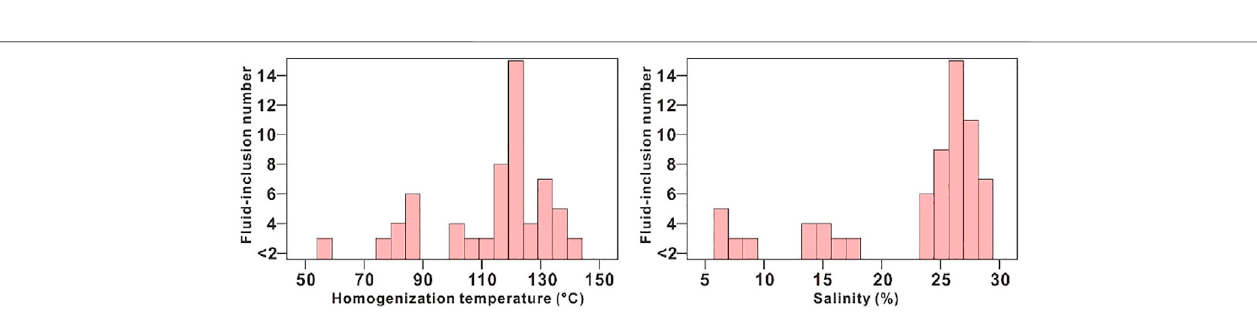
FIGURE 6 | Histograms showing homogenization temperatures (left) and salinities of the sucrosic dolomites in the studied interval.